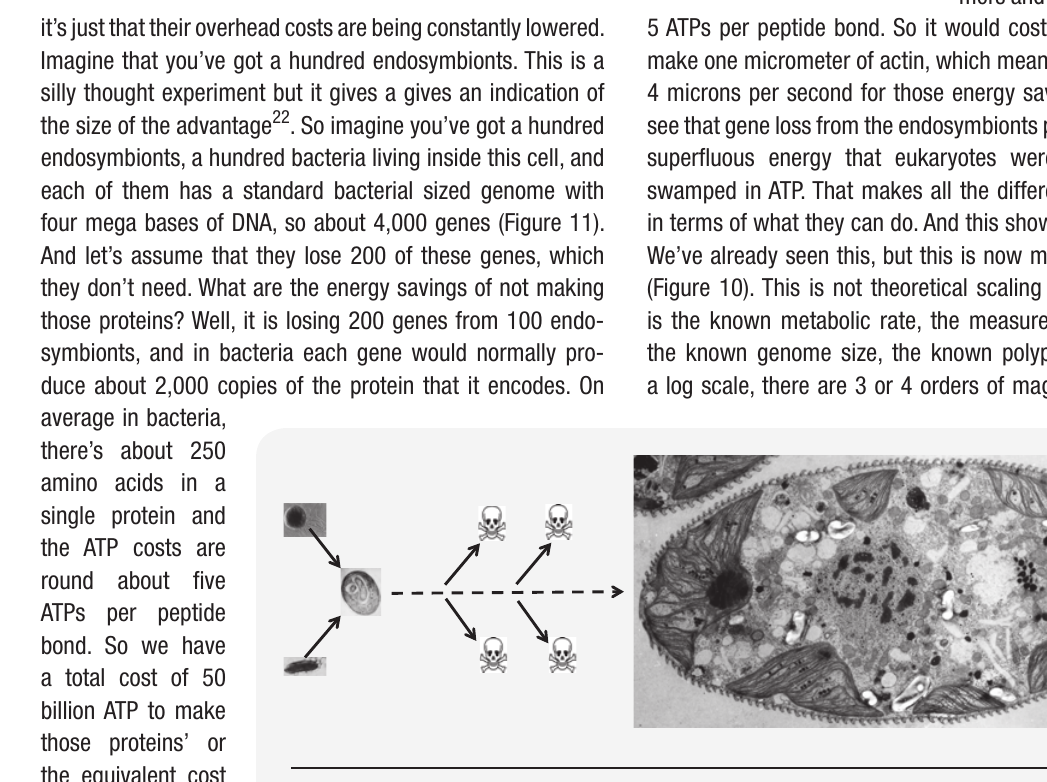
Figure 12. The central problem in eukaryotic evolution. A rare endosymbiosis between two prokaryotes (left) gives rise to an endosymbiotic fi rst common eukaryotic ancestor (FECA). Selection for coadaptation between these cells could argu- ably have driven the evolution of eukaryotic traits such as the nucleus and sex, ultimately giving rise to a complex last eukaryotic common ancestor (LECA, right, represented visually by the alga Euglena). There are no surviving evolutionary intermediates, implying that eukaryotes evolved relatively rapidly, in small proto-sexual populations. Photomicrograph of Euglena courtesy of M.